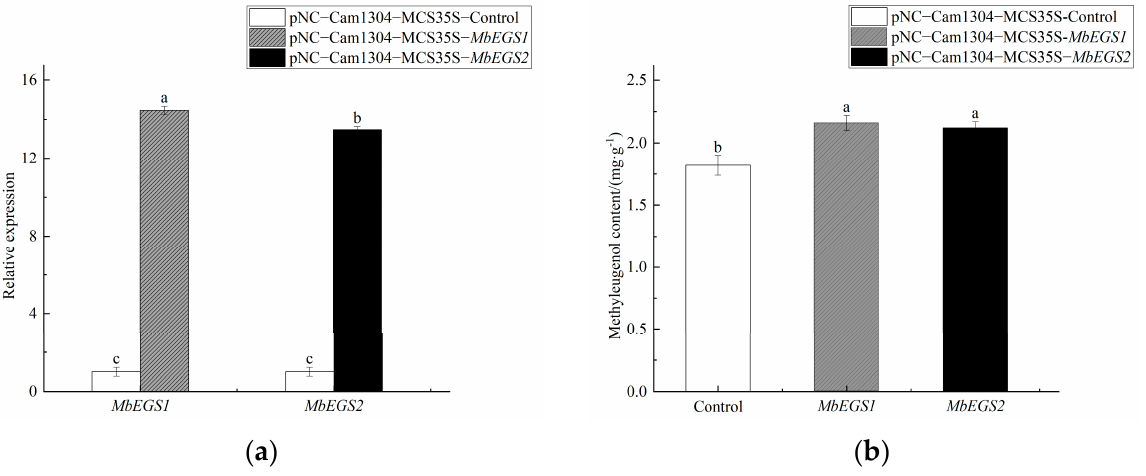
Figure 3. MbEGSs genes transcription level analysis ( a ) and contents of methyleugenol ( b ) in the overexpression treatment groups. Note: Different lowercase letters indicate significant differences ( p < 0.05).